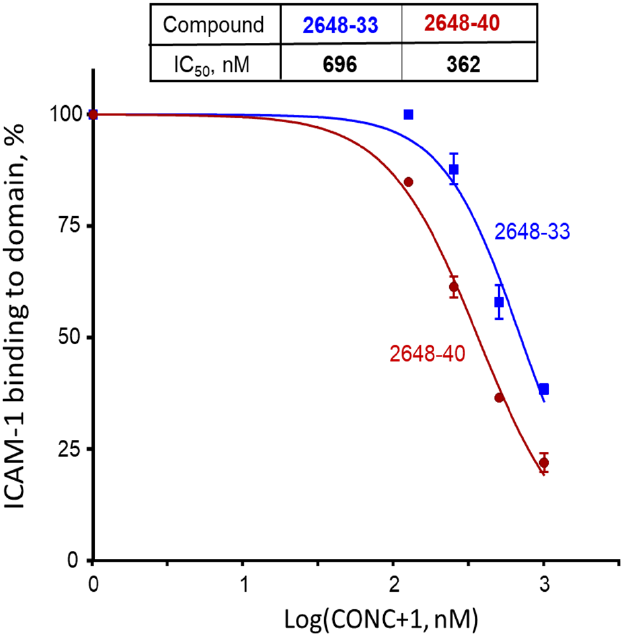
Figure 6. Inhibition of ICAM-1 binding to bead-bound DBL2 β 3 PF11_0521 domain by compounds #33 (blue) and #40 (brown). Dots indicate averages and error bars are SEMs of two independent experiments (biological replicates), each performed in duplicate. We measured 100% binding in the absence of compounds, using binding buffer supplemented with the same concentration of DMF as samples with compounds. CONC, compound concentration in